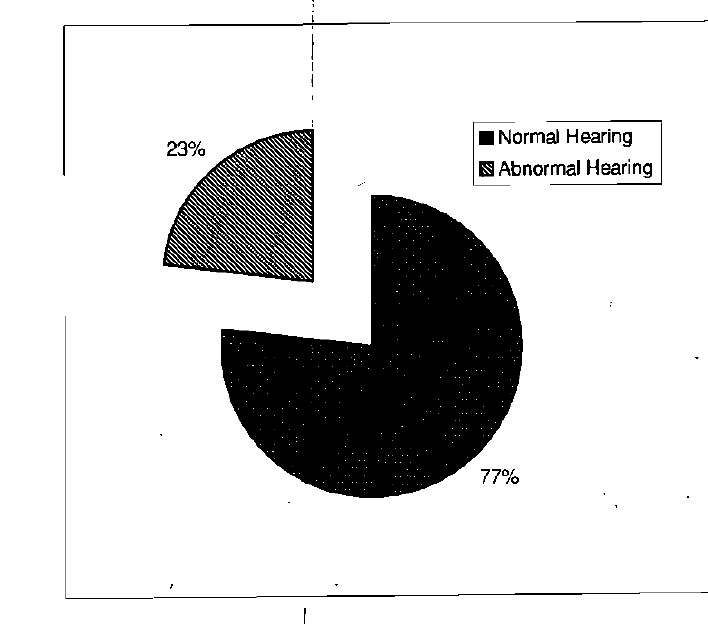
Figure 1: The prevalence of hearing loss in HIV/AIDS subjects (n =